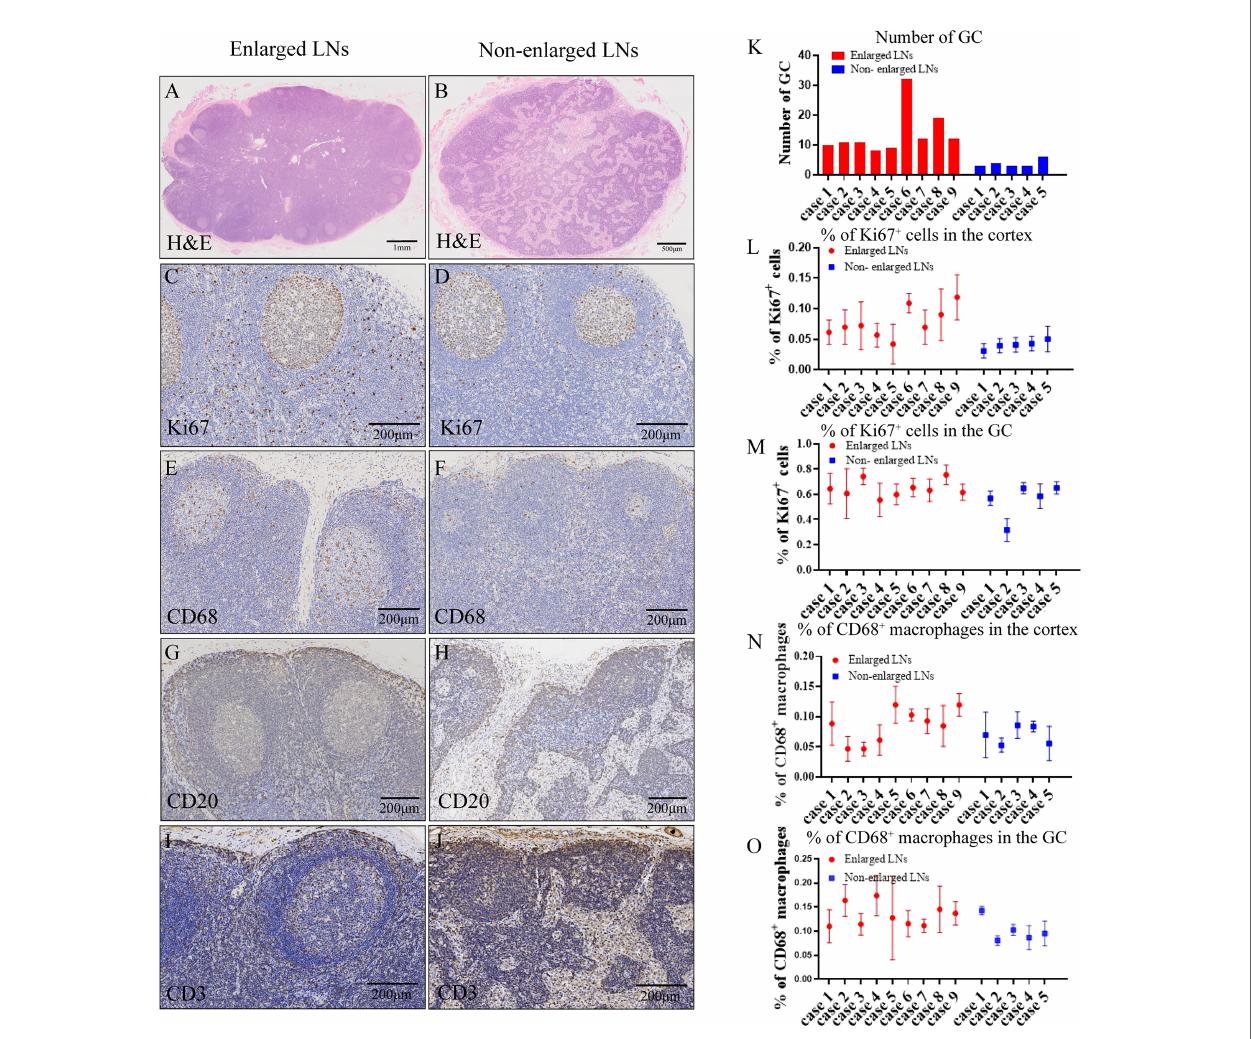
FIGURE 3 | Histological characteristics of lymph nodes. (A, B, K) Hematoxylin and eosin (H&E) staining (A, B) showing microscopic characteristics of lymph nodes (LNs) and number (K) of germinal centers (GCs) in one HE-stained section. (C, D, L, M) Immunohistochemistry (IHC) staining of Ki67 (C, D) and proportion of Ki67- positive cells (L, M) in the cortex or GC of enlarged and non-enlarged LNs. (E, F, N, O) IHC staining of CD68 (E, F) and proportion of CD68-positive macrophages (N, O) in the cortex or GC of enlarged and non-enlarged LNs. (G, H) IHC staining showing the increased CD20-positive B cells in the enlarged LNs. (I, J) IHC staining showing the increased CD3-positive T cells in the enlarged